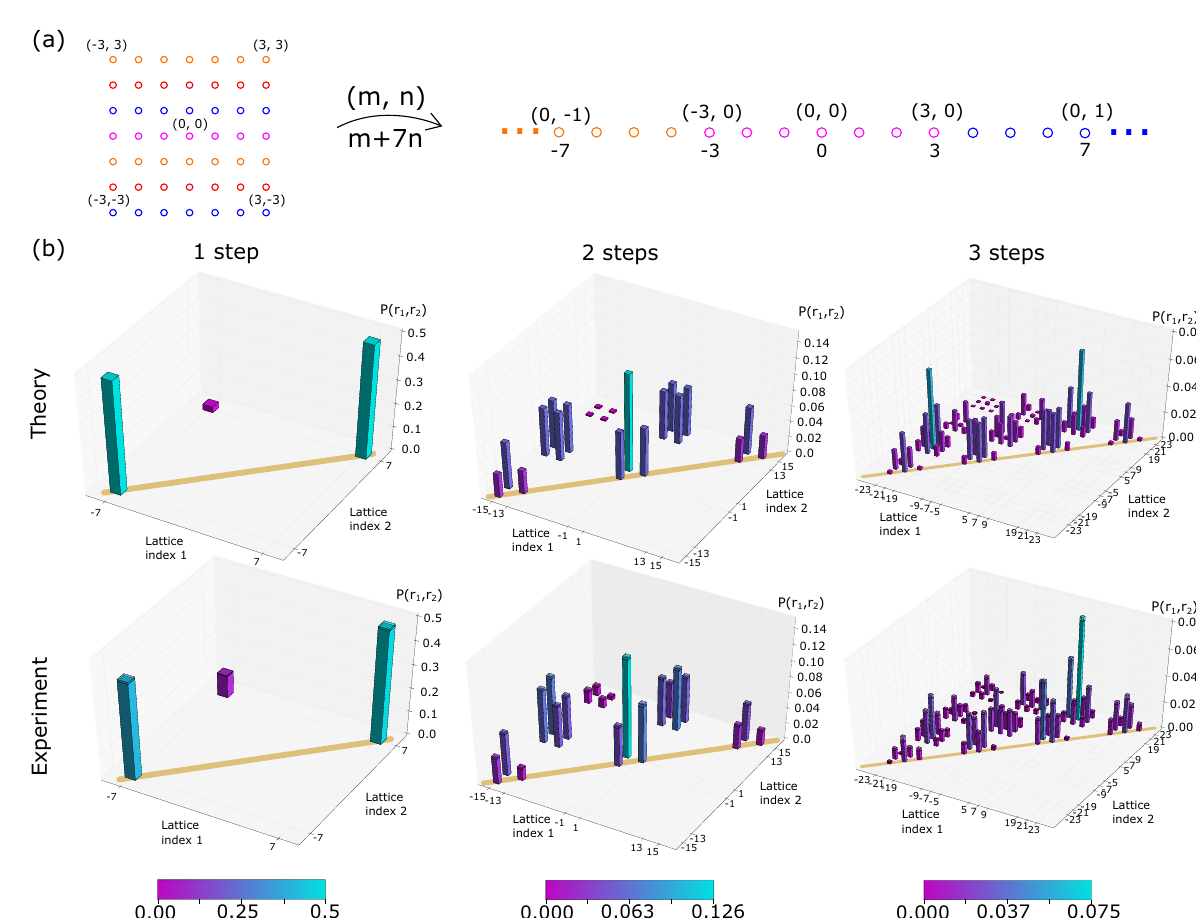
Fig. 5 Experimental results for two-photon 2D-QW. a In order to obtain a three-dimensional representation of the distributions, the two- dimensional lattice was linearized in the following way: ( m , n ) = m + 7 n , with m , n ∈ [ − 3, 3]. The fi gure graphically shows the linearization map. b Comparison between the theoretical predictions and the measured experimental distributions with two-photon inputs. Shaded regions on top of each bar correspond to the experimental errors. The error bars were obtained through a bootstrapping approach. The bunching probabilities are highlighted by the yellow